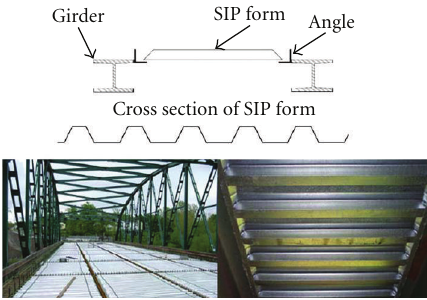
Figure 15: Stay-in-place bridge